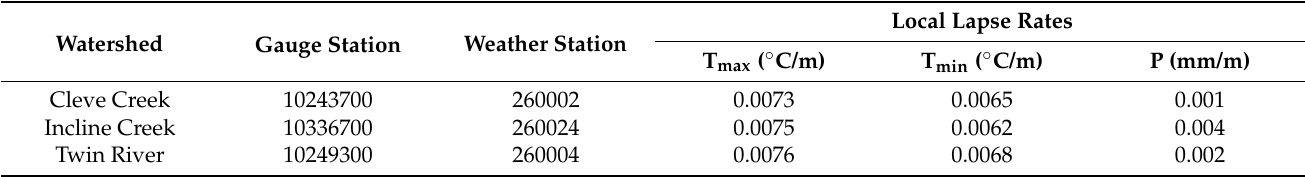
Table 1. The gauge station, weather station and local lapse rates used in this study.